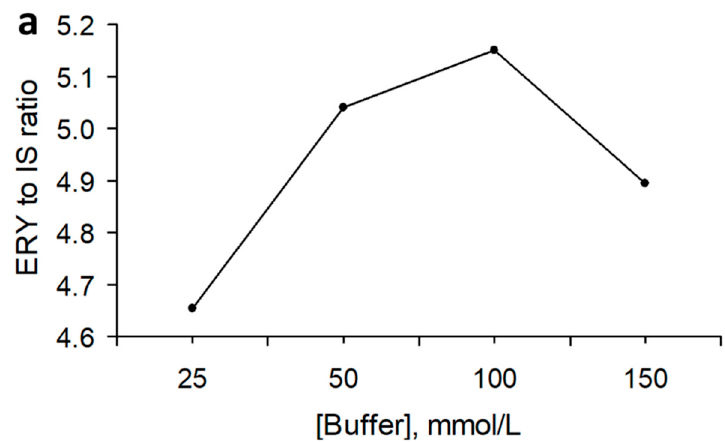
Figure 2. Effect of the ( a ) buffer concentration and ( b ) pH on the rate of the derivatization reaction between DEPC and ERY. 2.3. Recovery and Matrix Effect Recovery was determined as recovery% = [(C2 − C0)/C1] × 100, where C2 is the concentration of the analyte in the final solution after spiking with a known concentration of standard, C0 is the original concentration of analyte in the initial solution and C1 is the added known concentration of standard. Thus, the whole blood was spiked with four different concentration levels of the analytes within the linear range of 55–440 nmol/L. As presented in Table 1, for each concentration of analyte added, three replicates were analyzed and the recoveries, computed as above, were close to 100% at each concentration. Table 1. Recovery experiments. C0 and C2 are the mean of three replicates.